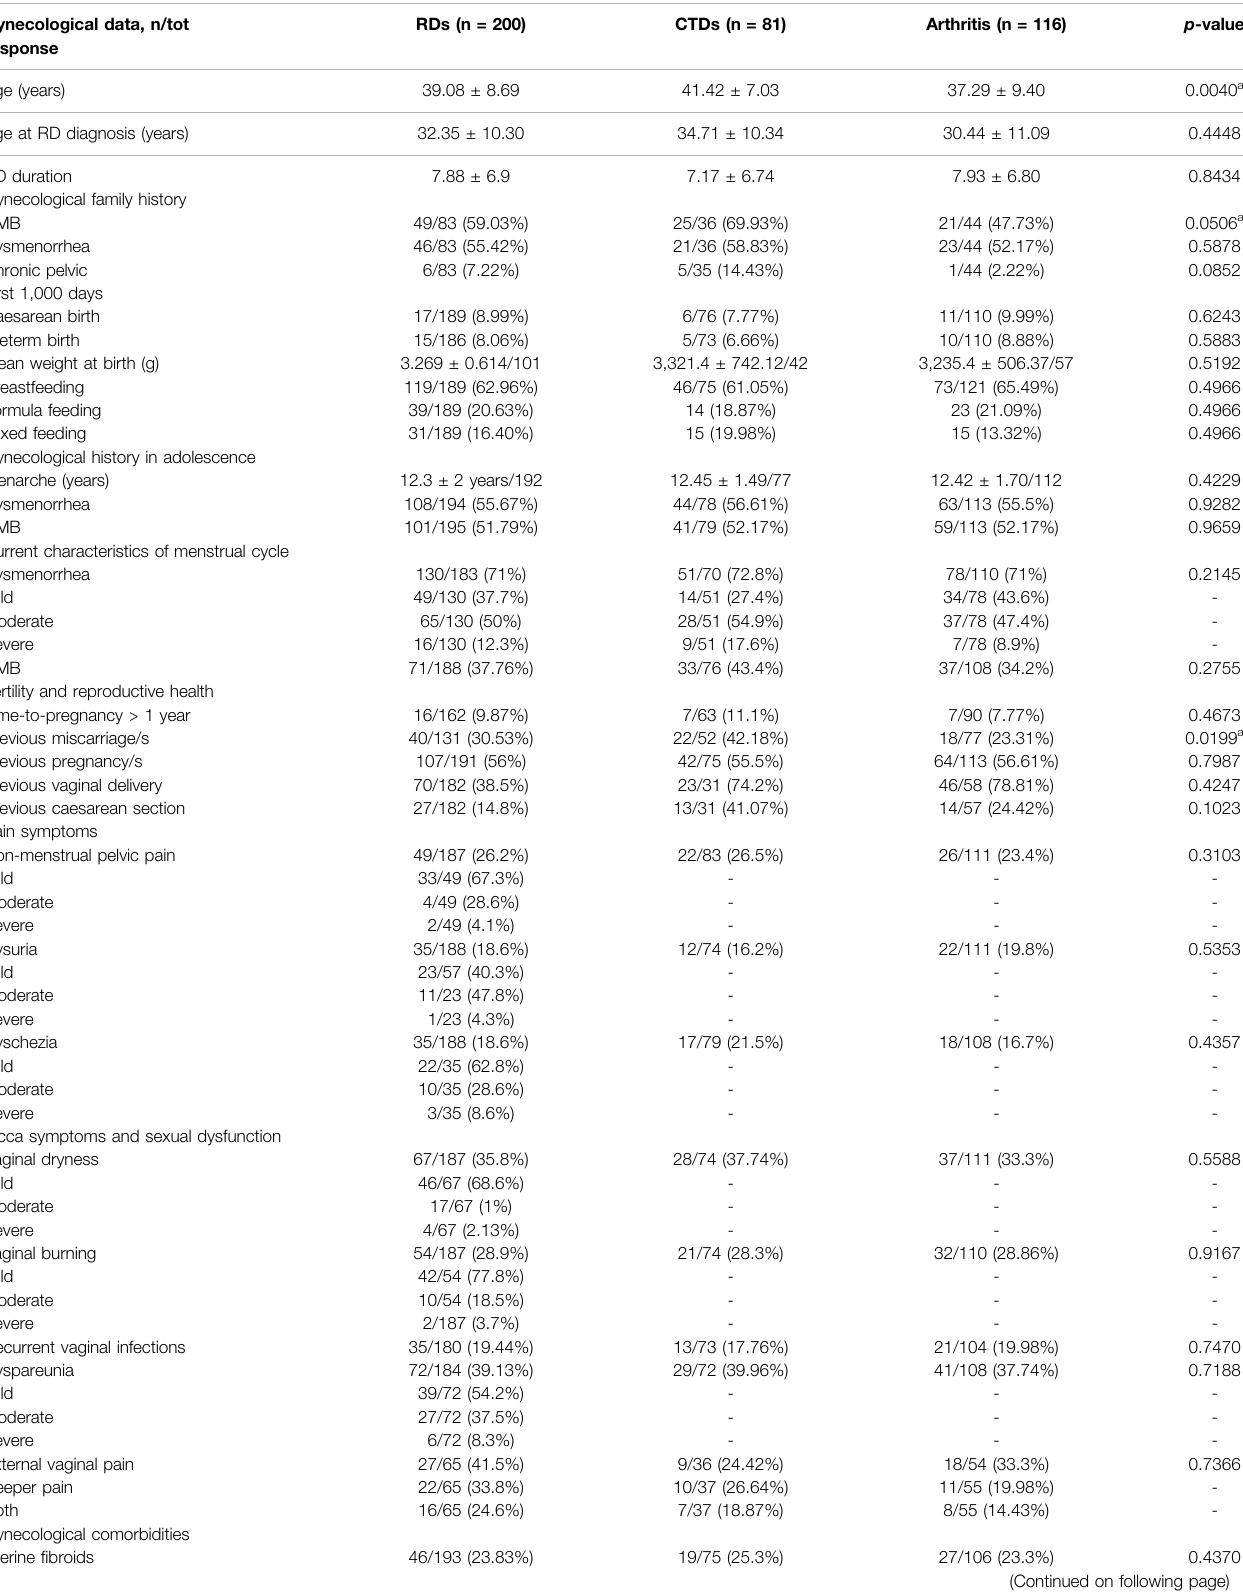
TABLE 2 | Gynecological data of enrolled